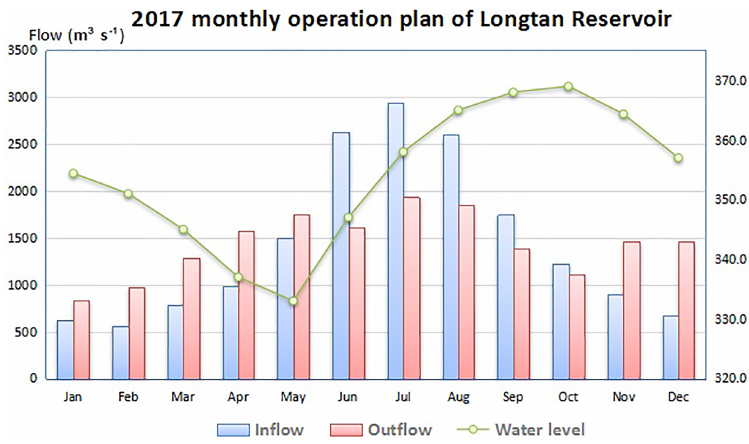
Figure 2. 2017 Monthly operation plan of Longtan